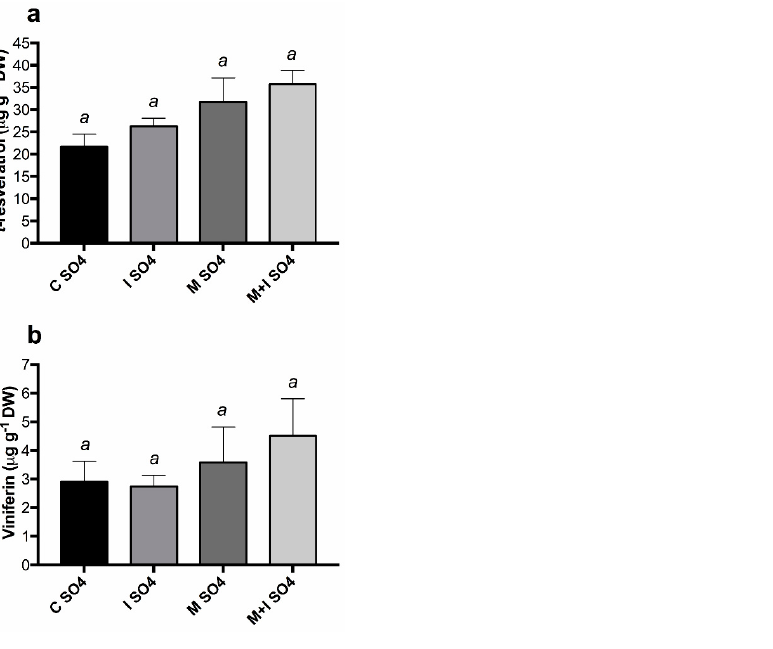
Figure 7. Stilbenes concentration in leaf tissues of ‘Glera’ plants grafted onto SO4 rootstock. ( a ) t -resveratrol quantification and ( b ) Viniferin quantification. Data are expressed as mean ± SD ( n = 10) of randomly selected plants over 2020 and 2021 seasons. Different lowercase letters above the bars indicate significant differences according to Tukey’s HSD test ( p < 0.05). C, control plants; I, Inducer-treated plants; M, AMF mixed inoculum-treated plants; M+I AMF mixed inoculum + Inducer-treated plants.